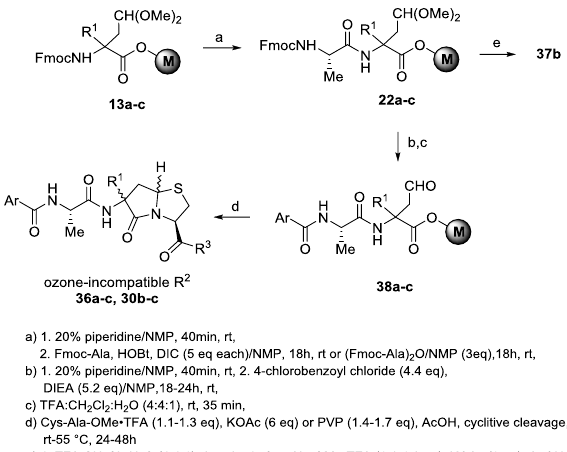
Scheme 10. Synthesis of Scaffold 3 compounds with ozone-incompatible groups and amino acid residues.